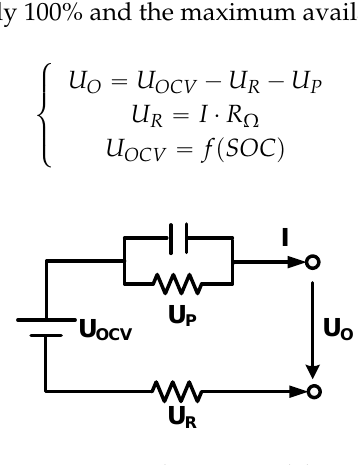
Figure 3. Thevinen model.